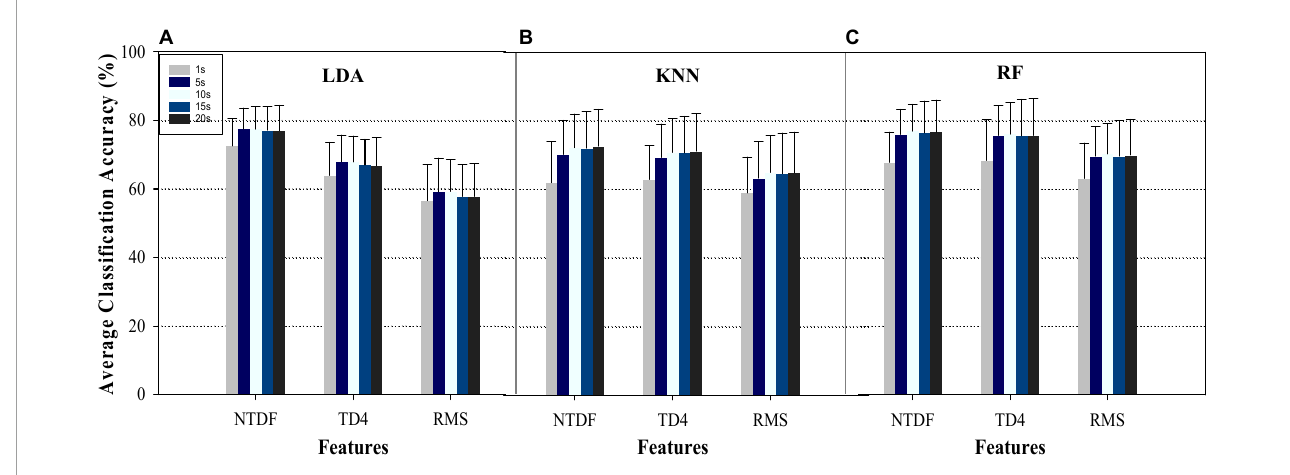
FIGURE3 Average classification accuracies of the different groups of signal recording length based on the Within-SRD Group Scenario using (A) LDA, (B) KNN, and (C) RF for NTDF, TD4, and RMS features across finger gestures and participants.